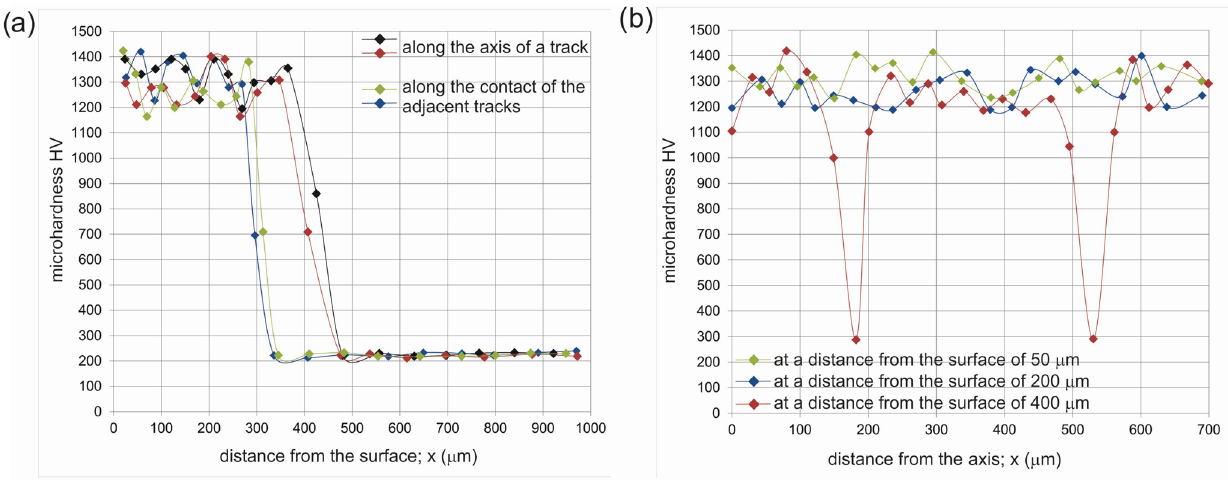
Figure 12. The microhardness profiles of laser borided layer produced on Nimonic 80A alloy at the laser beam power of 1.3 kW: ( a ) measurements along the axis of a track and along the contact of the adjacent tracks; ( b ) measurements along the straight line parallel to the surface.